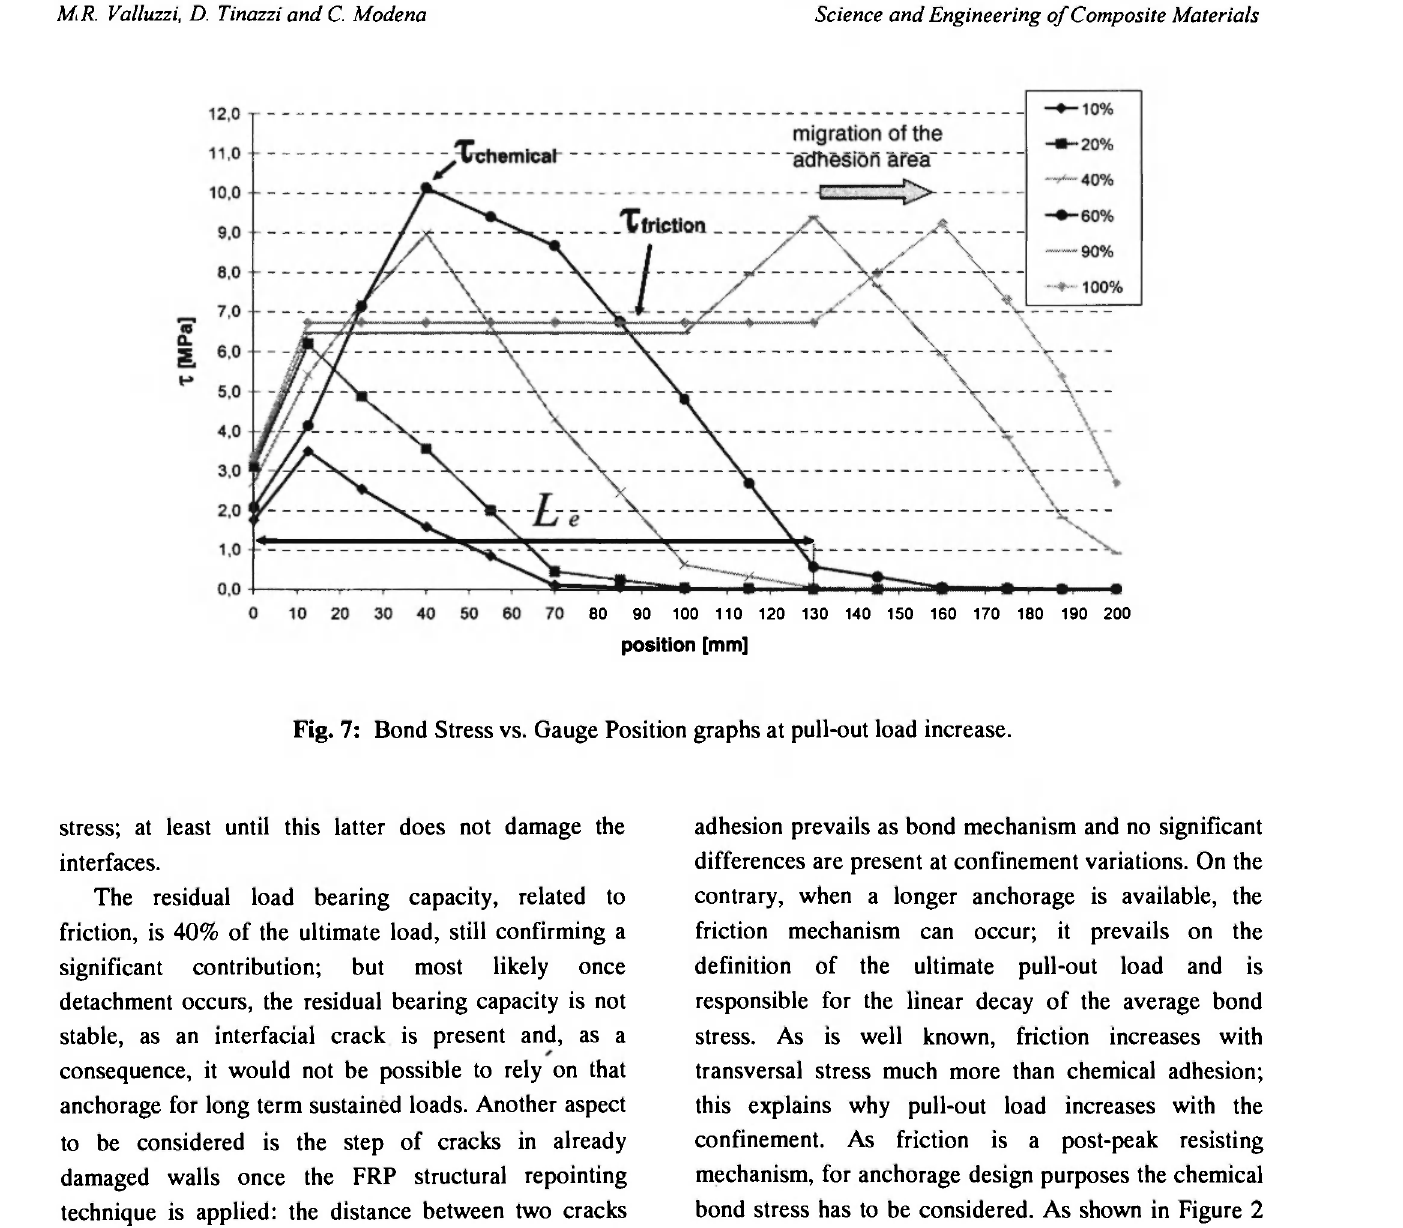
Fig. 7: Bond Stress vs. Gauge Position graphs at pull-out load increase.